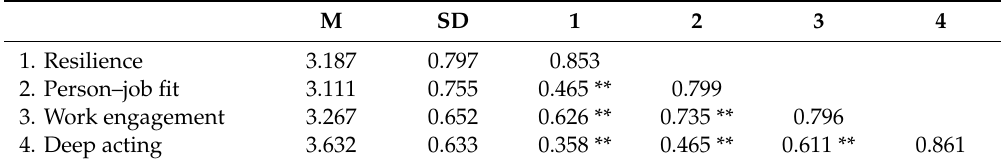
Table 3. Measurements of correlations and discriminant validity.